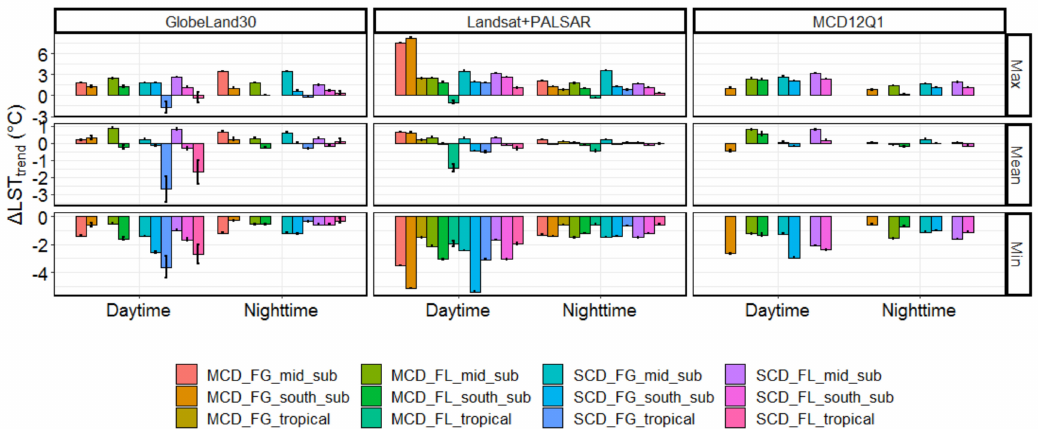
Figure 8. Annual daytime and nighttime LST di ff erences caused by the three datasets-based forest losses and gains estimated by MCD and adjusted SCD over the mid-subtropical zone (mid_sub), south-subtropical zone (south_sub), and tropical zone (tropical) from 2000–2010. The vertical lines on each bar represent the confidence interval at 95% estimated by t